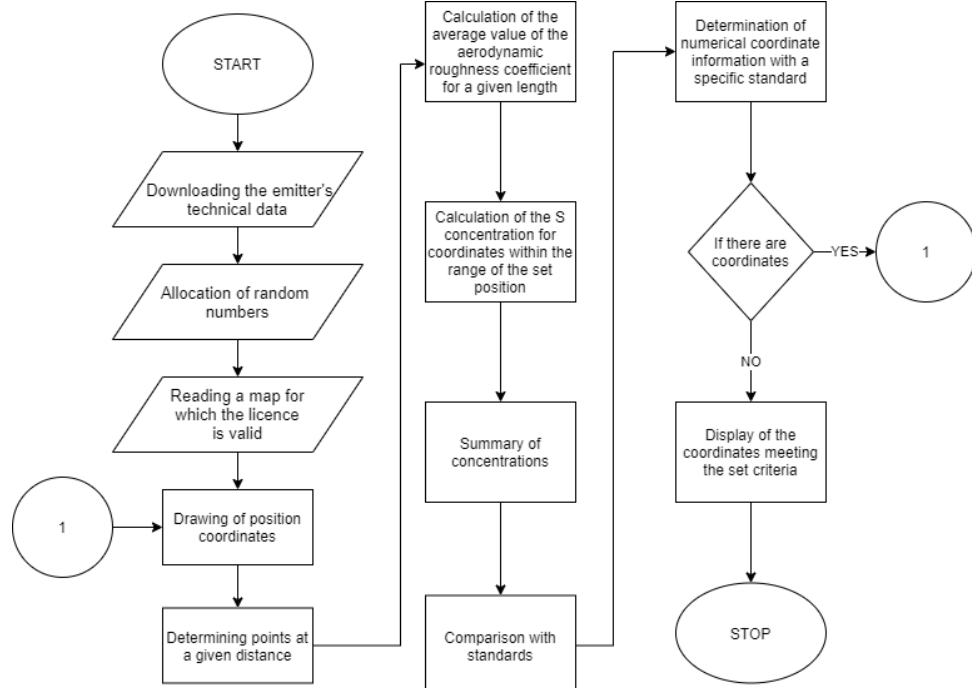
Figure 3. Block diagram describing how the application